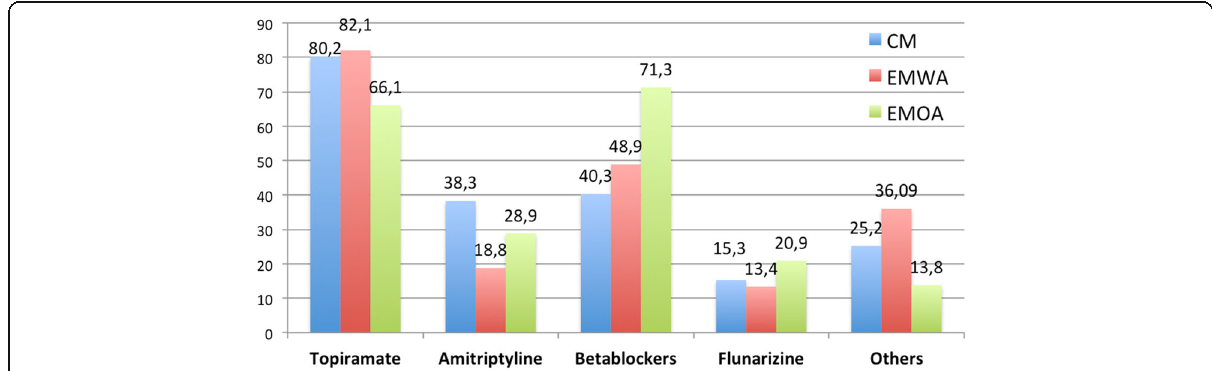
Fig. 1 First choice drugs in Chronic Migraine (CM) (blue), Episodic Migraine With Aura (EMWA) (red) and Episodic Migraine Without Aura (EMOA) (green). Percentage shows the pooled percentage of people who responded each drug as first or second choice in each